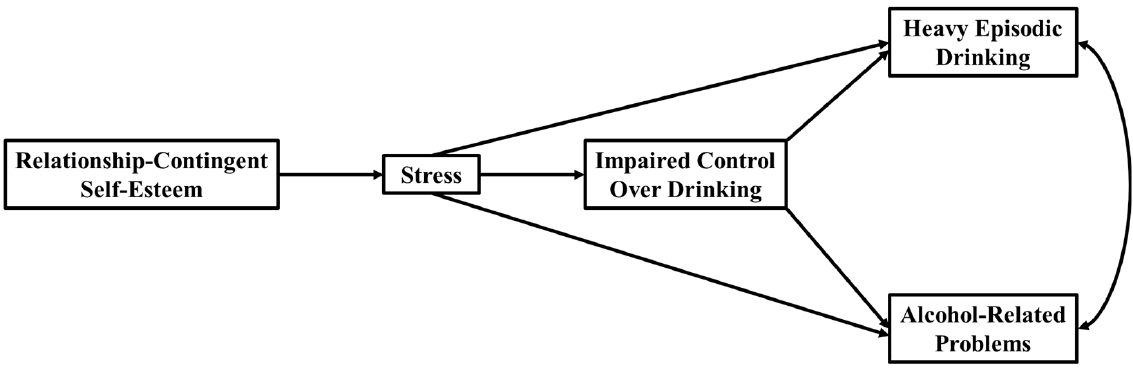
Figure 1. Conceptual model of all examined paths among the different variables in the model.